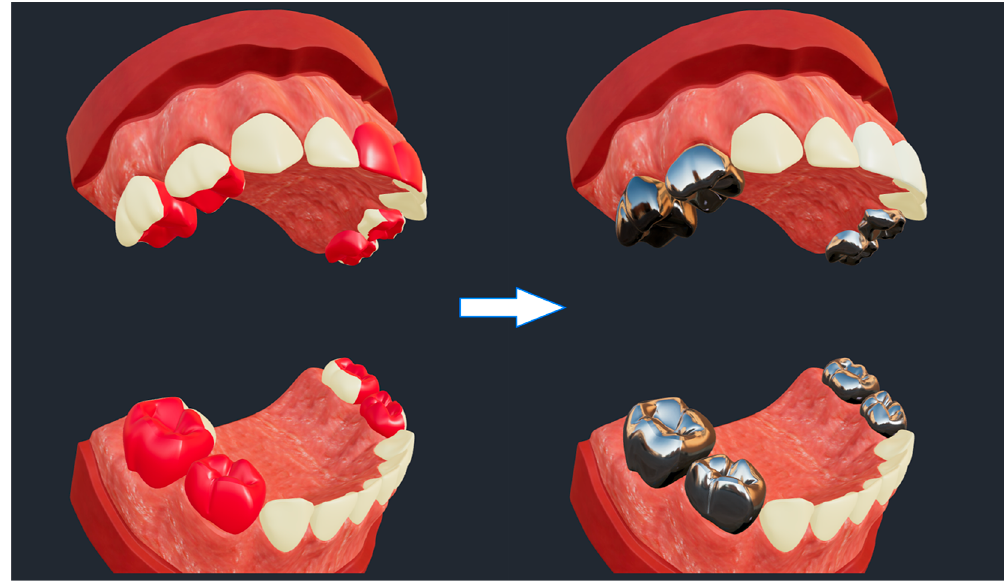
Figure 4. Representation of a simulated dental restorative treatment for a severe case of early childhood caries (i.e., multiple caries-affected primary teeth) that can be used for demonstration and educational purposes with families of patients. Caries lesions are displayed with red color in the model on the left-hand side (i.e., pre-treatment). The model on the right-hand side illustrates the restorative result that would be achieved using stainless-steel crowns for the restoration of posterior teeth and tooth-colored ceramic crowns for the restoration of the maxillary anterior teeth.